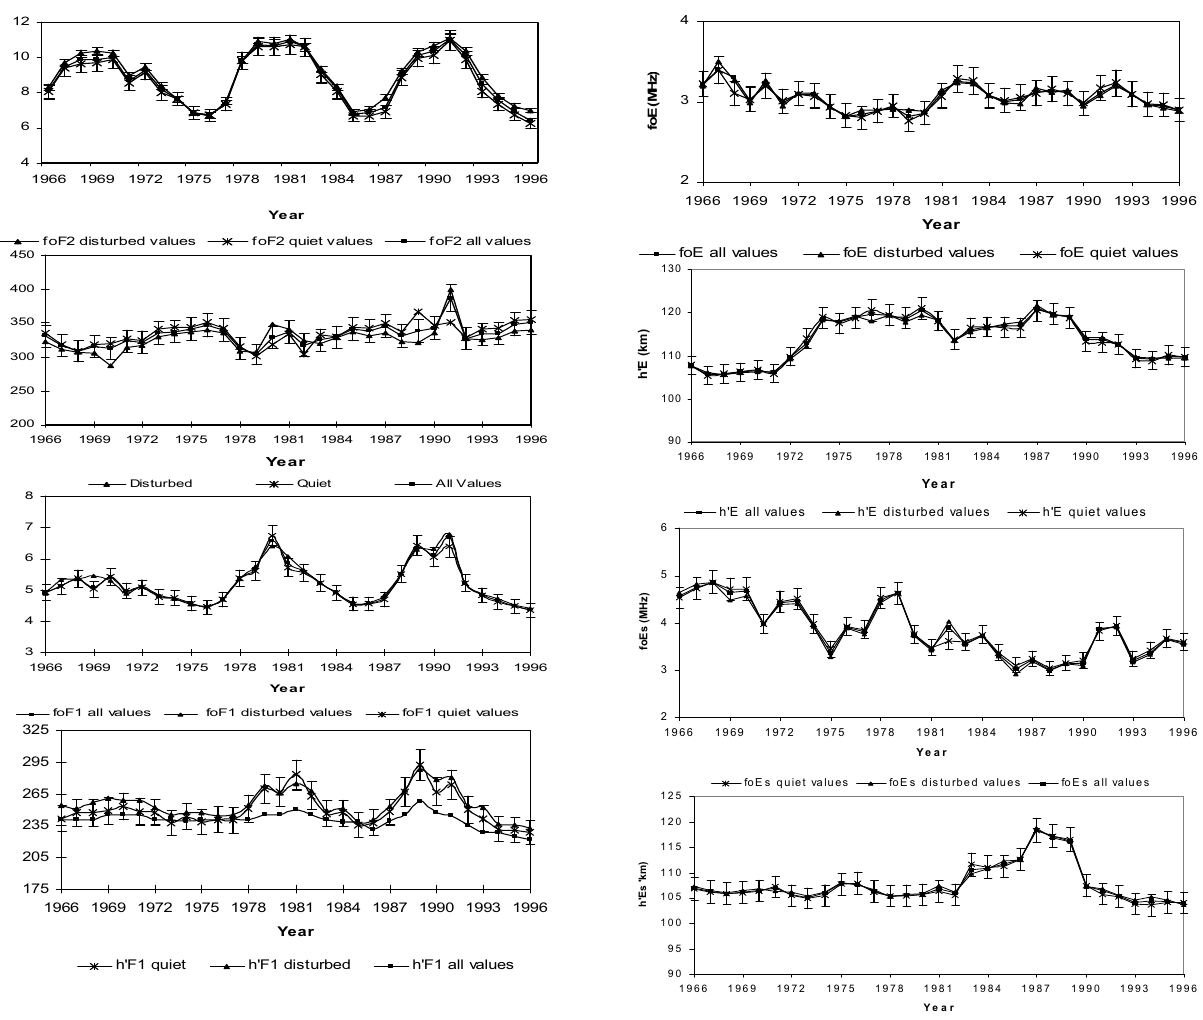
Fig. 2a. From top to bottom: the annual variation, from 1966 to 1996, of fo F2 (panel a ), of h 0 F2 (panel b ), of fo F1 (panel c ) and of h 0 F1 (panel d ) for whole values (line with square), quiet values (line with star) and disturbed values (line with triangle). Fig. 2b. Similar to Fig. 2a for fo E, h